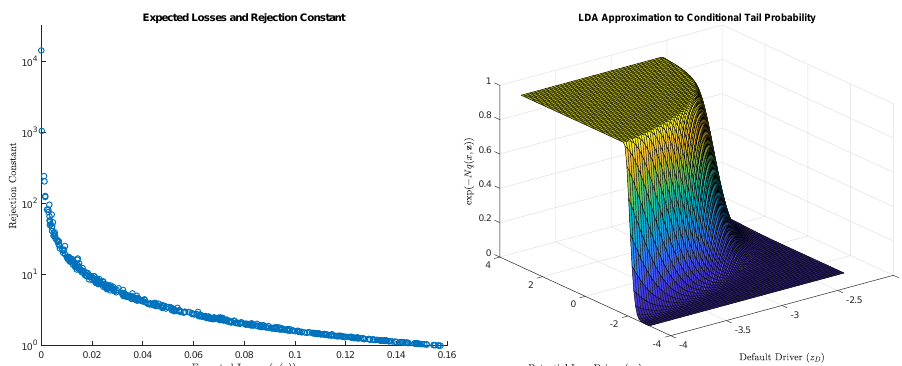
Figure 1. The left panel of this figure illustrates the relationship between expected losses µ ( z ) and the second-stage rejection constant ˆ c = ˆ c ( x , z ) , in the two-factor model. The right panel illustrates the graph of the LDA approximation of Equation (13). Parameters (randomly selected using the procedure in Section 5.3) in both panels are ( P , ρ D , ρ L , ρ I , ρ S , a , b , N ) = (0.0063, 0.3964, 0.2794, − 0.3356, − 0.7599, 0.6497, 0.5033, 134) and the threshold is x = 0.1575. Mean losses are E [ L i ] = 0.0029, and the probability that losses exceed the threshold x is on the order of 50 basis points. Points in the left panel were obtained by generating 1000 realizations of the systematic risk factors from their actual distribution (as opposed to the first-stage IS distribution) using the indicated parameter